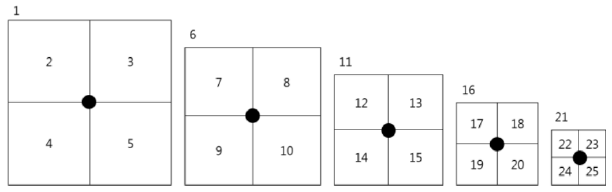
Figure 9. Multi-dimensional search window (five steps).